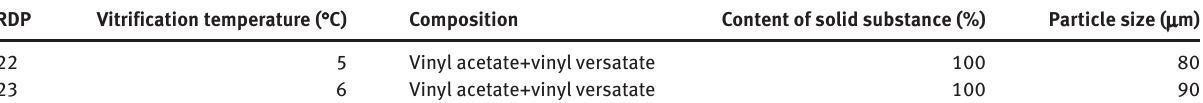
Table 2: Characteristics of the RDP